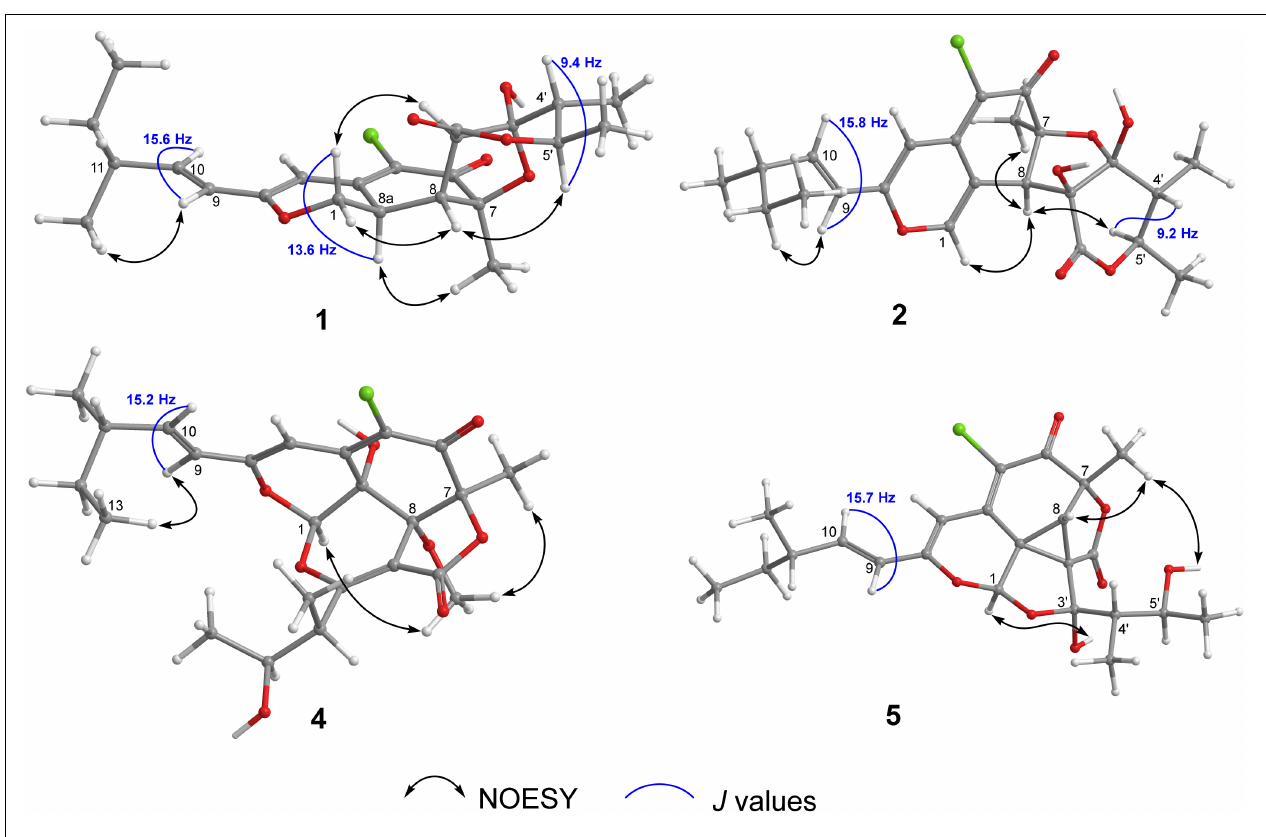
FIGURE 3 | Key NOESY correlations of compounds 1, 2, 4, and 5.